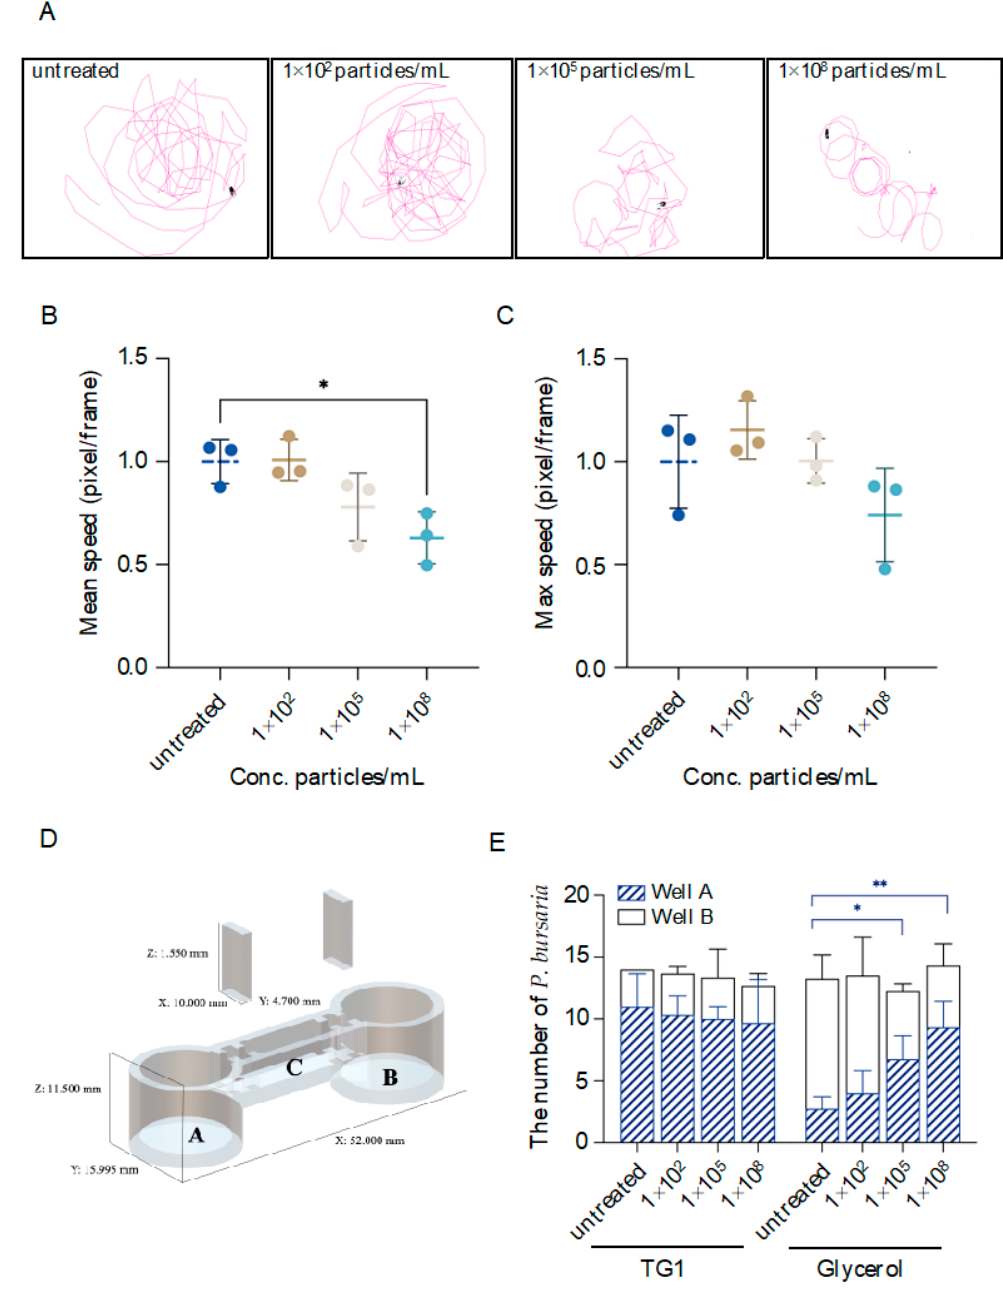
Figure 3. Quantitative analysis of locomotion activity, prey pursuit, and avoidance behaviors of MPs-exposed P. bursaria . ( A ) P. bursaria were exposed to MPs at concentrations of 1 × 10 2 , 1 × 10 5 , and 1 × 10 8 particles/mL, respectively, for 24 h. On the day of the experiment, individual cells in each group were randomly picked, and their trajectories were monitored and recorded for 2 min under a microscope. Moving trajectories were further plotted and analyzed using the TrackMate plug-in in the Image J (Fiji) program to obtain mean speed and max speed, which are represented as fold change to the untreated group in ( B , C ), respectively. The data are represented as the mean ± SD of three independent experiments, and asterisks above the line denote a significant difference (* p < 0.05) between means identified by the line. ( D ) A schematic of a two-well testing apparatus for investigating prey pursuit and avoidance behaviors of P. bursaria following MPs exposure. This testing apparatus has two wells (designated as “A” and “B”) connected by a canal (designated